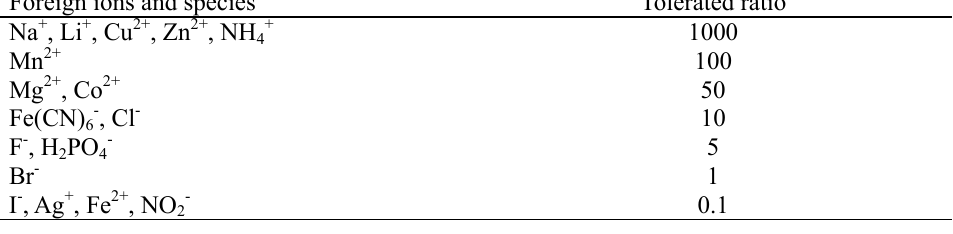
Table 1 Influence of foreign ions and species on the determination of 1.25×10 -5 M paracetamol.